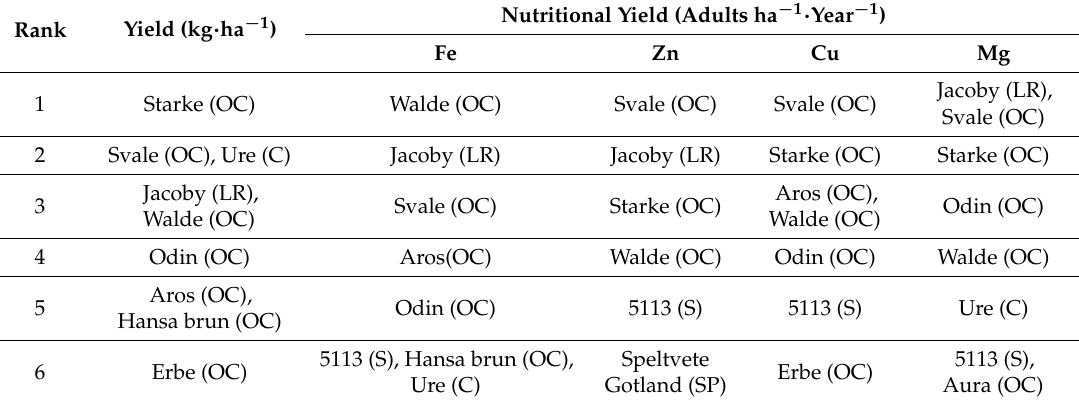
Table 4. Rankings of the winter wheat genotypes with the highest yield or nutritional yield and stability for Fe, Zn, Cu, and Mg according to AMMI stability analysis (i.e., combined high values of yield and nutritional yield with PC1 values close to 0; Figures 1 and 2). The genotype groups to which the genotypes belong are shown in parenthesis. Genotypes sharing a ranking could not be differentiated from each other according to nutritional yield and stability